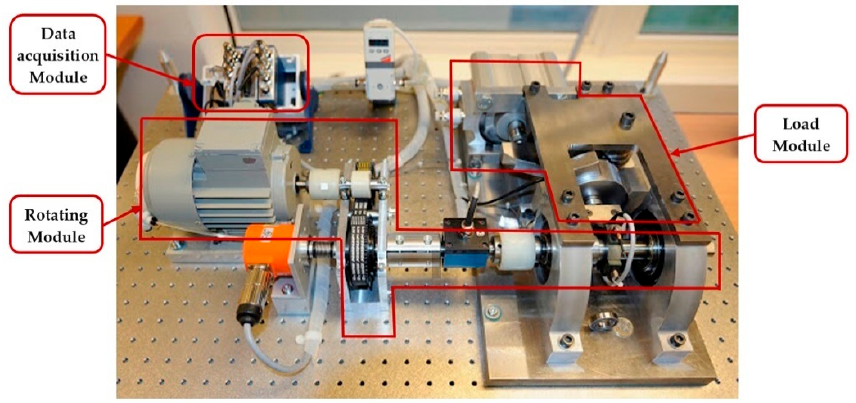
Figure 1. Main modules of the experimental platform.